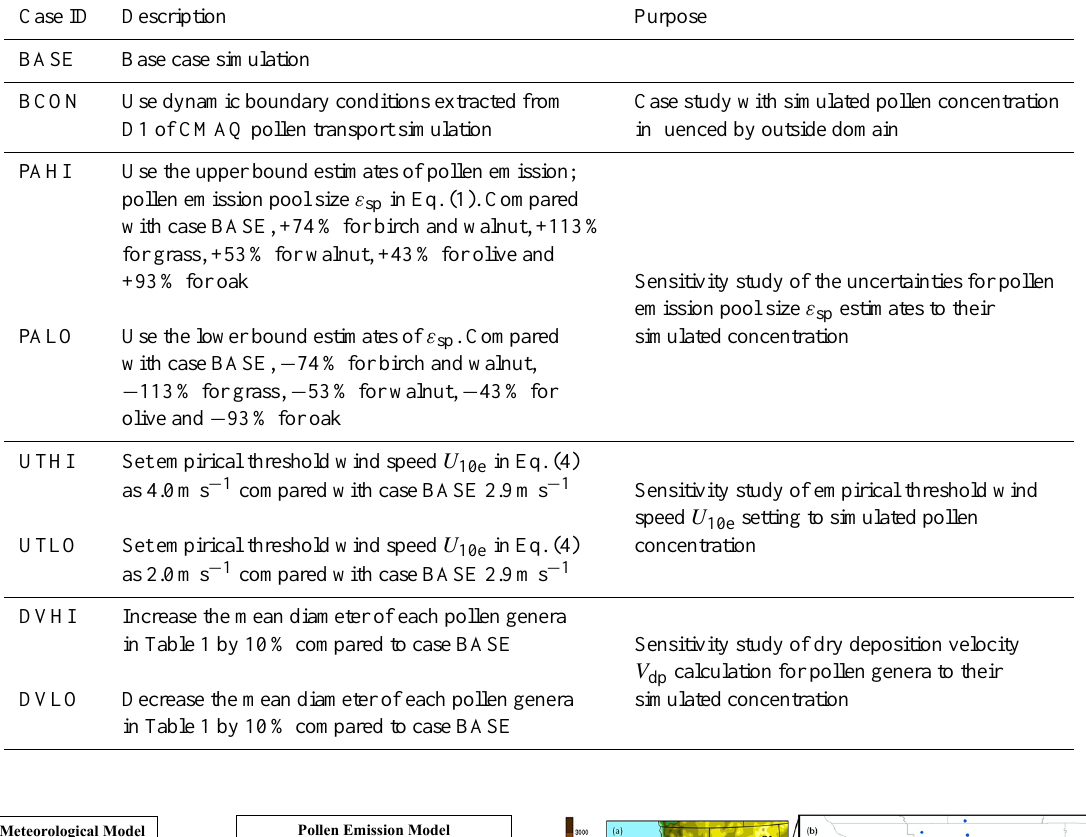
Mesoscale Meteorological Model (WRF)